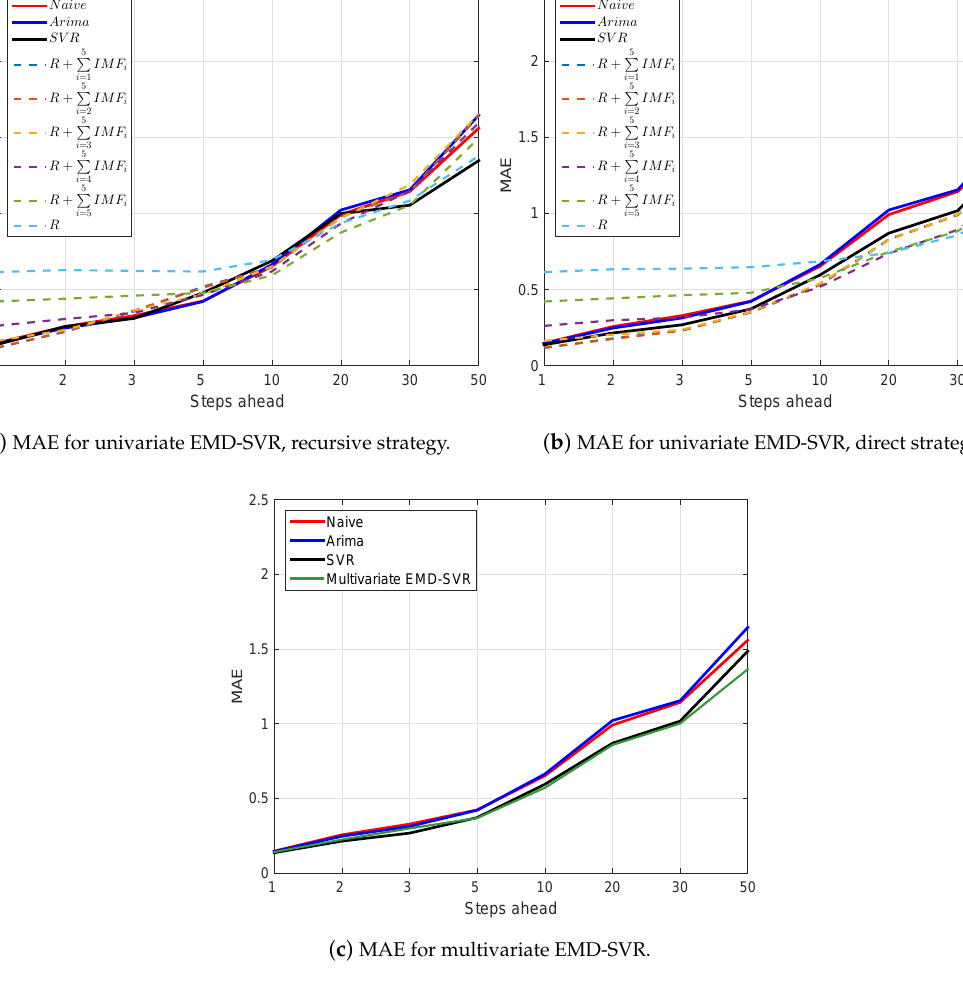
Figure 5. Mean absolute error (MAE) as a function of the forecast horizon for all forecasting models: naive, ARIMA ( p , d , q ) , SVR on the original data, univariate and multivariate EMD-SVR with input vector m = p + d lagged values. Smaller MAE indicate better forecasts. Direct strategy univariate EMD-SVR with different number of components (Equations (5)–(8)) outperform all benchmarks for at all steps ahead. Multivariate EMD-SVR also outperforms all benchmarks for h ≥